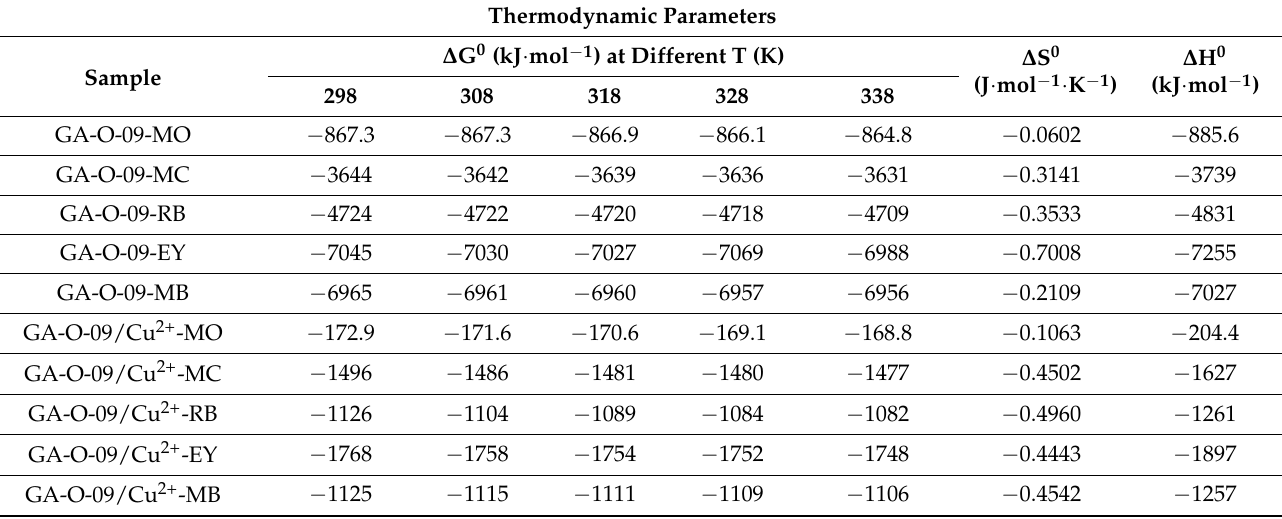
Table 3. Thermodynamic parameters calculated for the removal of dye by the GA-O-09/Cu 2+ and GA-O-09 hydrogels (C 0 = 250 mg/L, dosage = 3